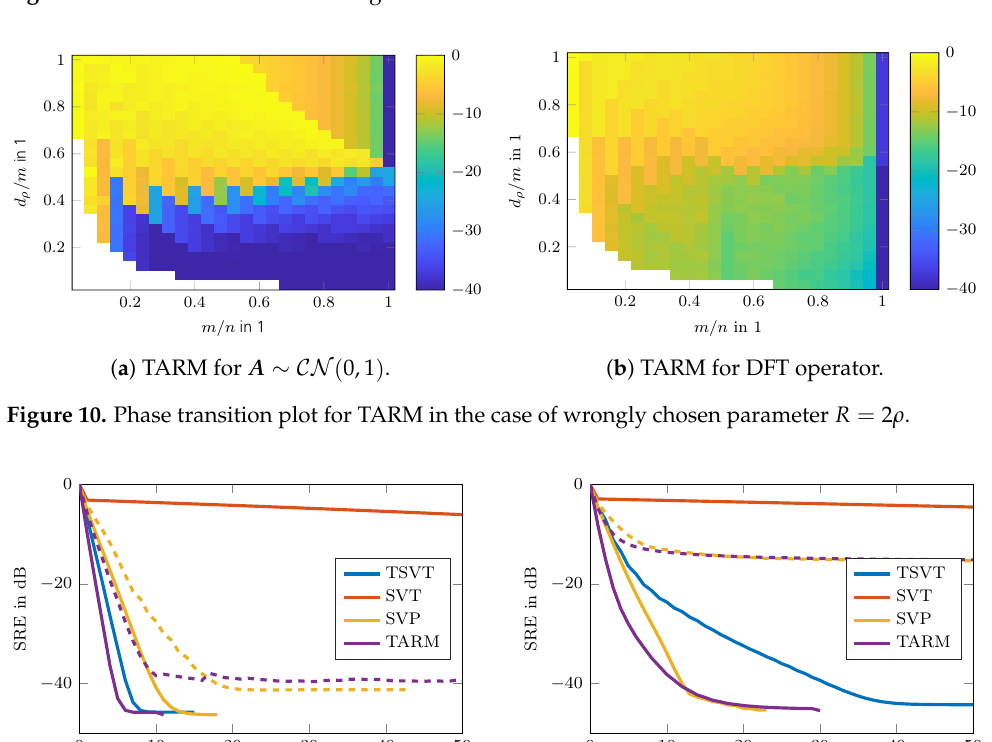
Figure 9. Phase transition of ARM algorithms in SRE in dB.